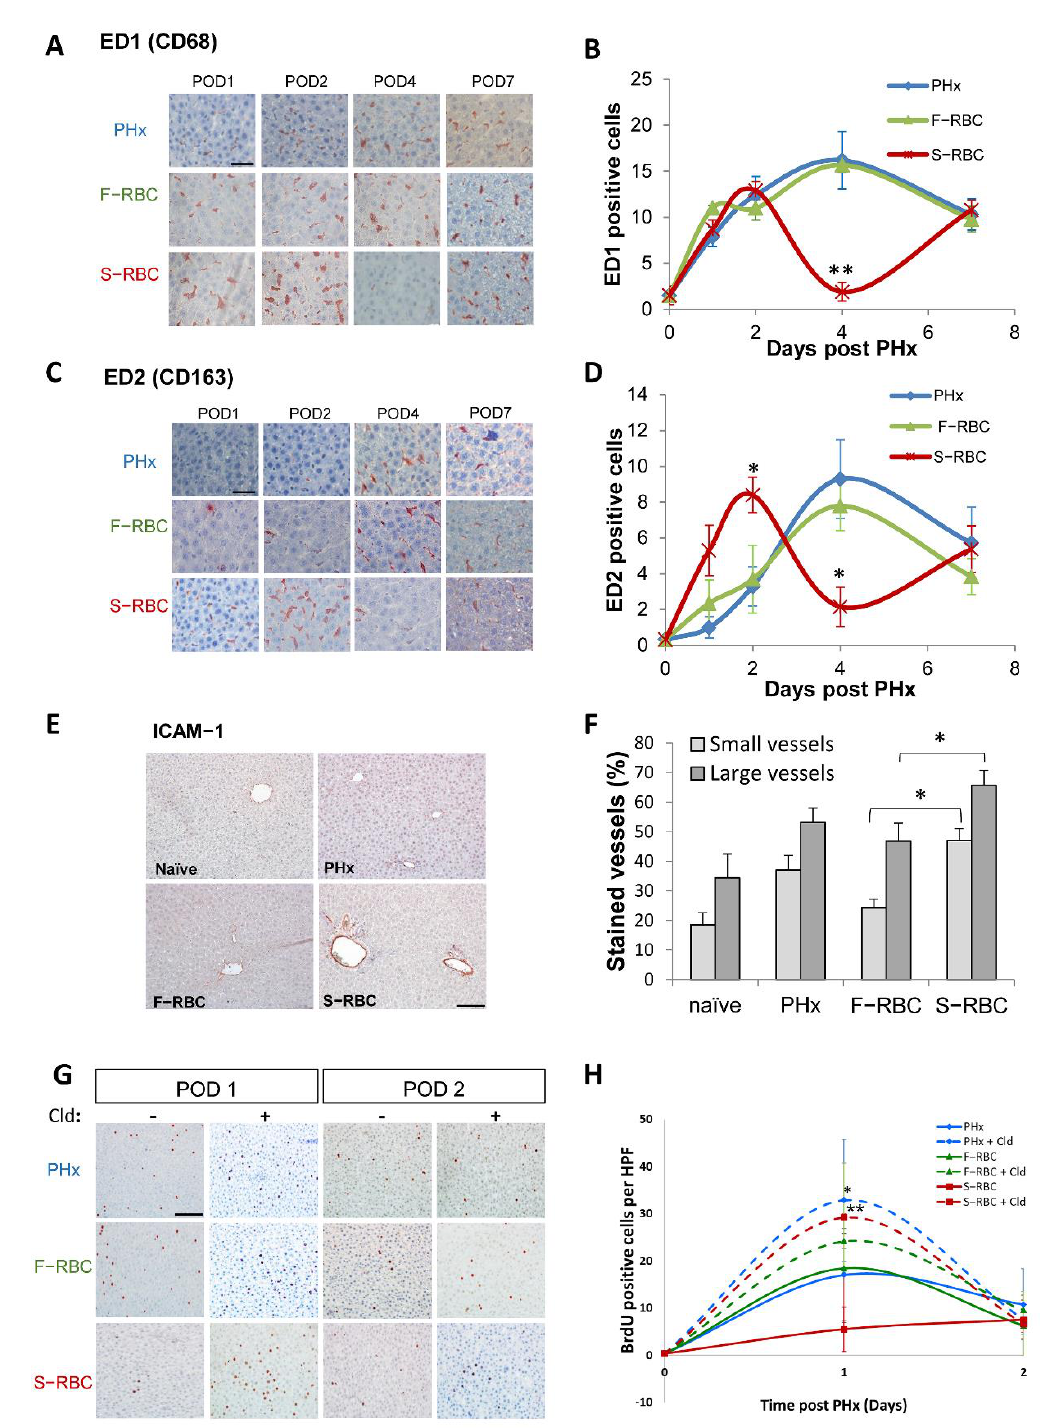
Figure 4. Transfusion with S-RBC following PHx and bleeding causes changes in the number of hepatic macrophages and activated macrophages. ( A ) Representative images of liver sections stained with anti-CD68, showing macrophages in the liver in the various groups on days 1, 2, 4, and 7 following PHx (POD = post-operative day); Bar =50 m and apply for all. ( B ) Quantification of the number of CD68+ cells per HPF. Average of 10 fields per animal from the different liver lobes. n = 5 – 10 per group. * p < 0.05, ** p < 0.01. ( C ) Representative images of liver tissue sections stained with anti-CD163 showing activated macrophages in the liver in the various groups, 1, 2, 4, and 7 days following PHx (POD = post-operative day); Bar = 50 µ m and apply for all. ( D ) Quantification of the number of CD163+ cells per HPF. Average of 10 fields per animal from the different liver lobes. N = 5 – 10 per group. * p < 0.05, ** p < 0.01. ( E ) Representative images of ICAM-1 staining, one day post-